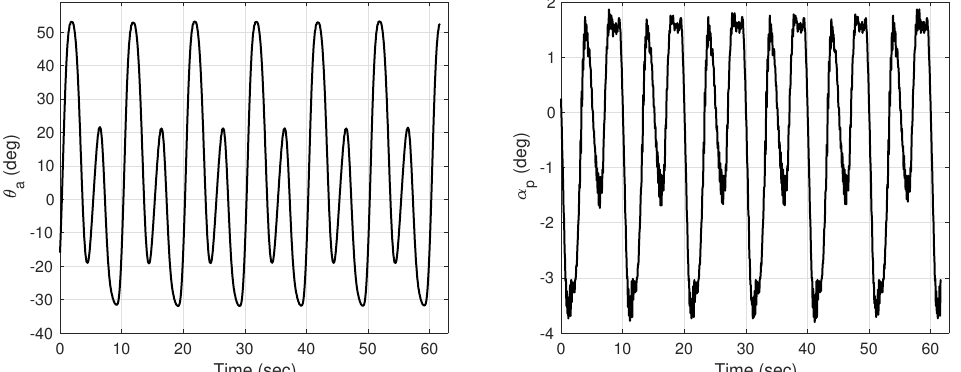
Figure 7. Load disk ( left ) and Pendulum ( right ) angular position response (closed-loop